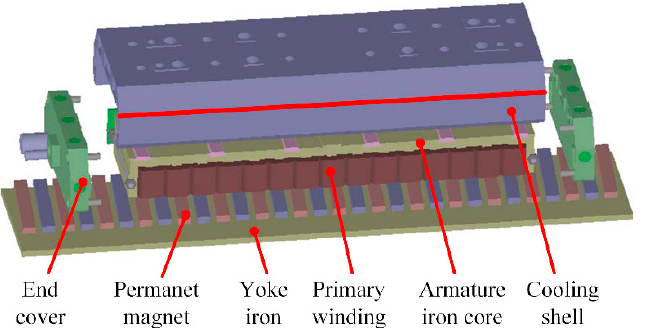
Figure 5. Structure diagram of the proposed PMLSM with skewed PMs. Reprinted with permission from ref. [43]. Copyright 2015 IEEE